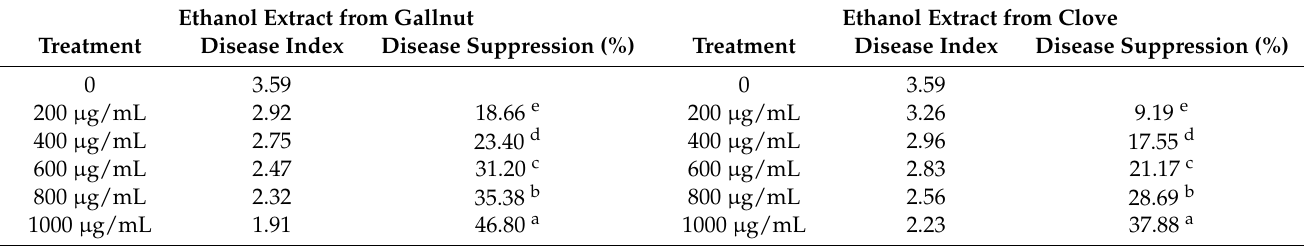
Table 4. Biocontrol efficiency of ethanol extracts from gallnut and clove against rice sheath blight pathogen R. solani under green house condition.